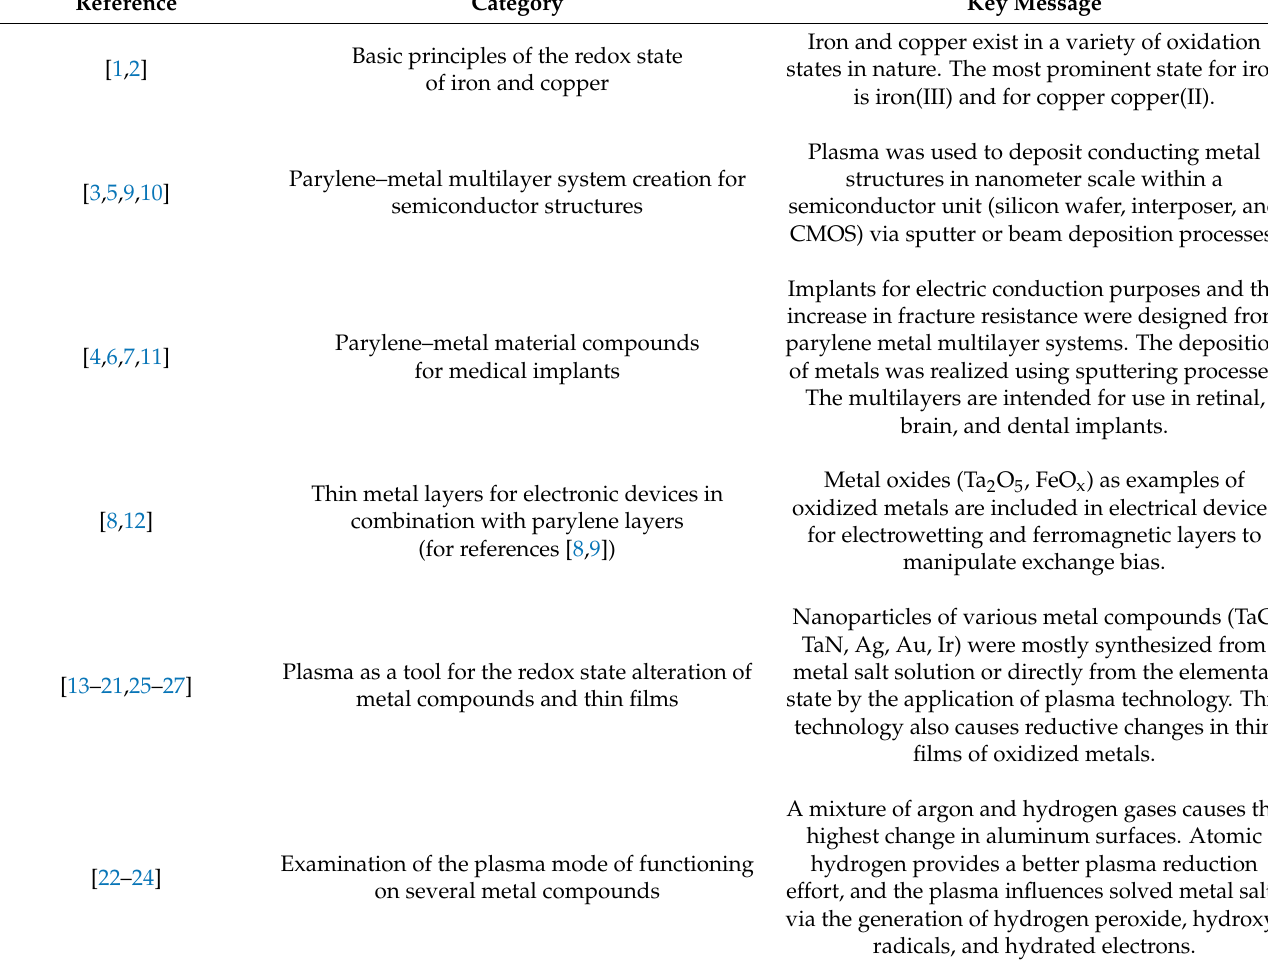
Table 1. A brief overview of the